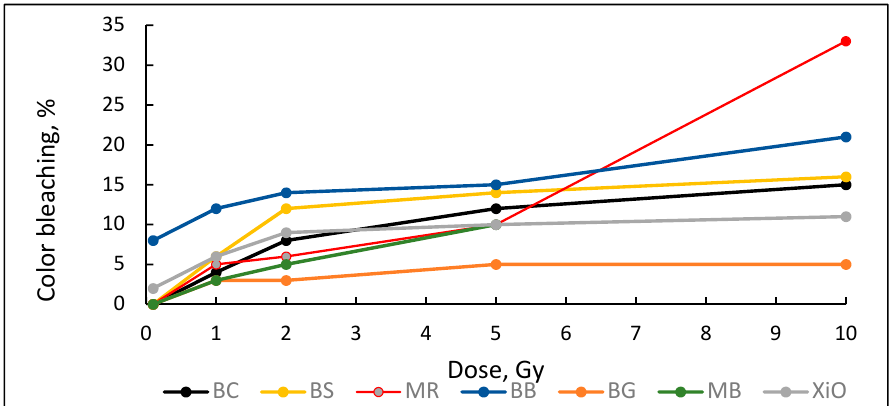
Gels 2023 , 8 , x FOR PEER REVIEW 9 of 17 Figure 8. Absorbance spectra and sensitivity of the irradiated brilliant green films. Decolorization efficiency/color bleaching effect in all 6 MeV irradiated PVA-dye gel films is shown in Figure 9.